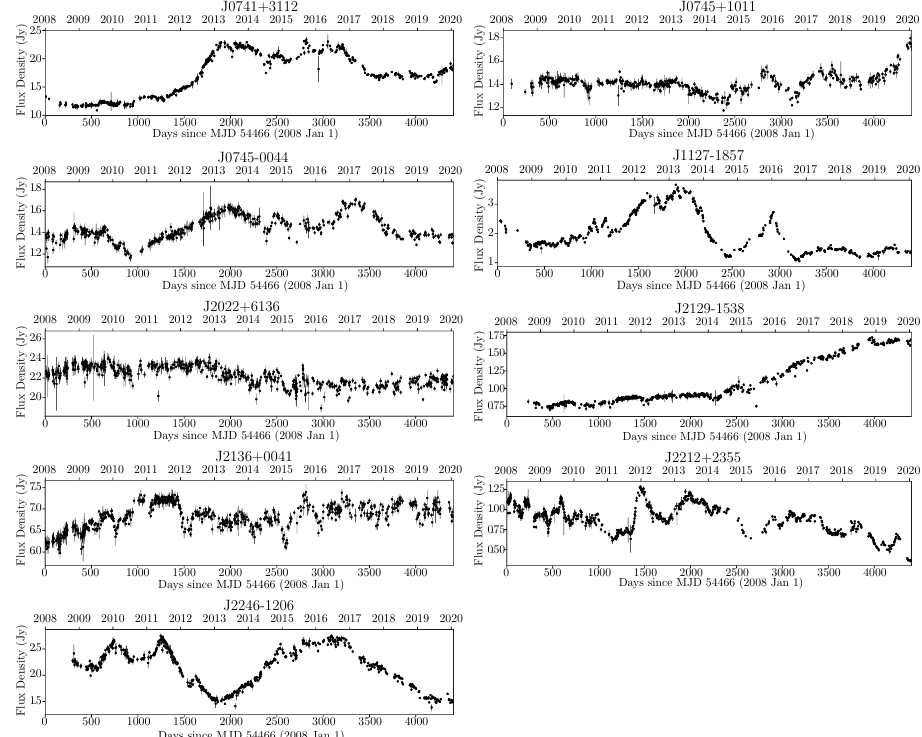
Figure 2. Fifteen-GHz radio light curves observed with the Owens Valley Radio Observatory (OVRO)